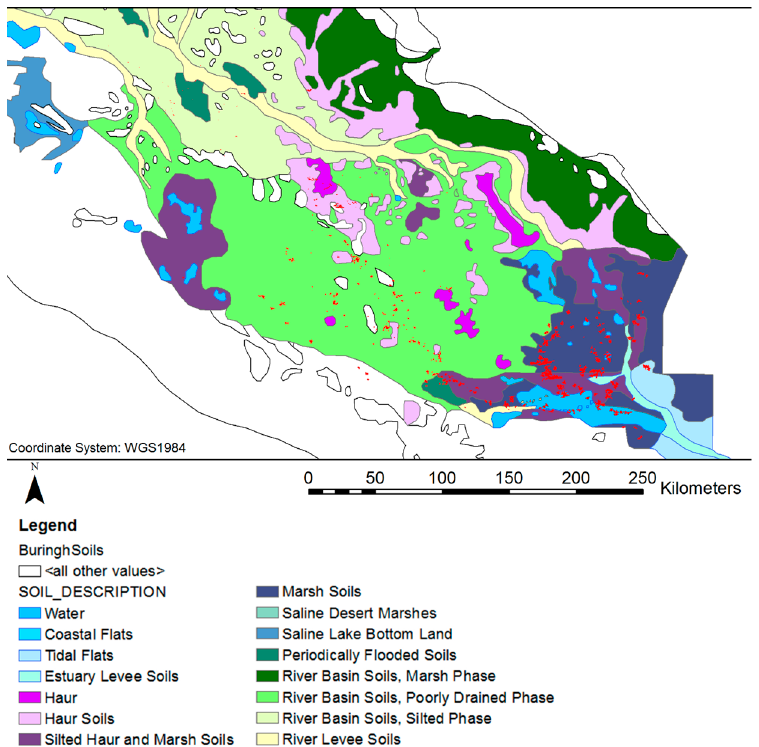
Figure 14. Where hollow ways were not located through shallow water or at the edge of bodies of shallow water, they were often found in areas of former marshland, including ‘haur’ (the Arabic word for ‘marsh’) [46].